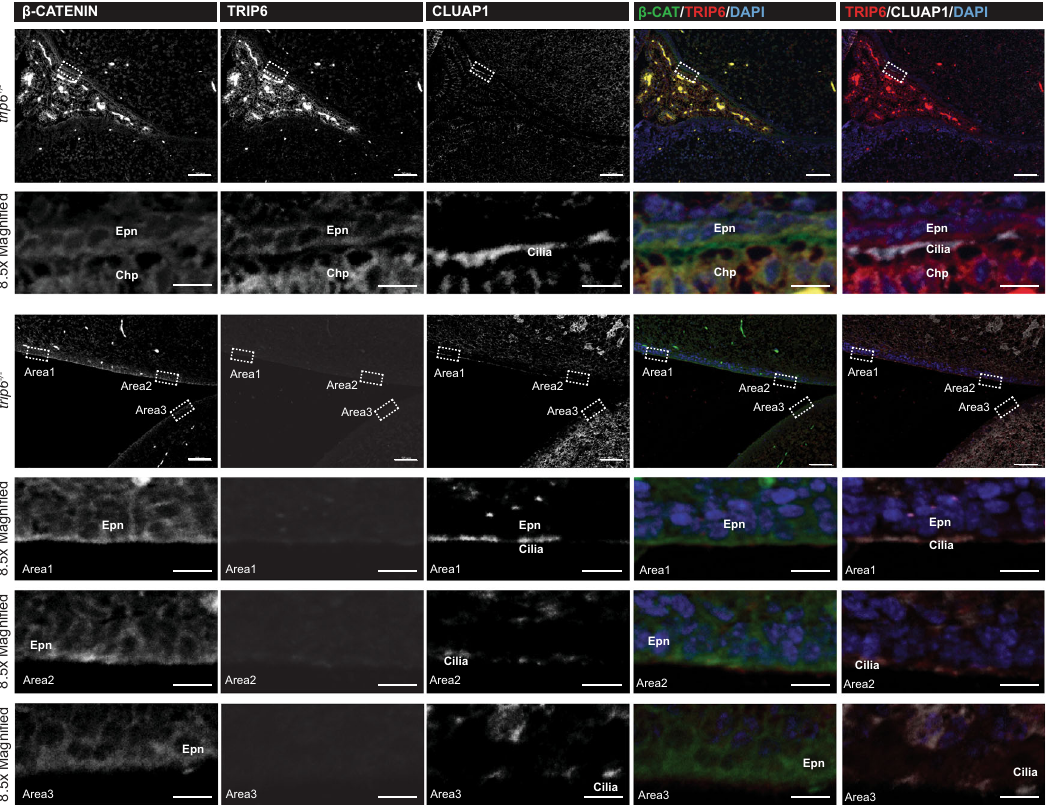
Fig. 6 Trip6 deletion affects ciliogenesis but not cell-cell adhesion. Immuno fl uorescence microscopy-based expression and localization analysis of cilia (CLUAP1) and cell-cell adhesion ( β -CATENIN) markers, as well as of TRIP6, in the LV of control ( trip6 + / − ) and trip6 − / − mouse brain. Their comparison demonstrates TRIP6 deletion and ciliation defects in trip6 − / − specimens, but no obvious adhesion defects. Magni fi cation panels depict selected areas (indicated by white frames in the low magni fi cation images), re-oriented with the ventricular lumen positioned at the lower part of each image. Epn ependyma, Chp choroid plexus. Scale bar: 50 μ